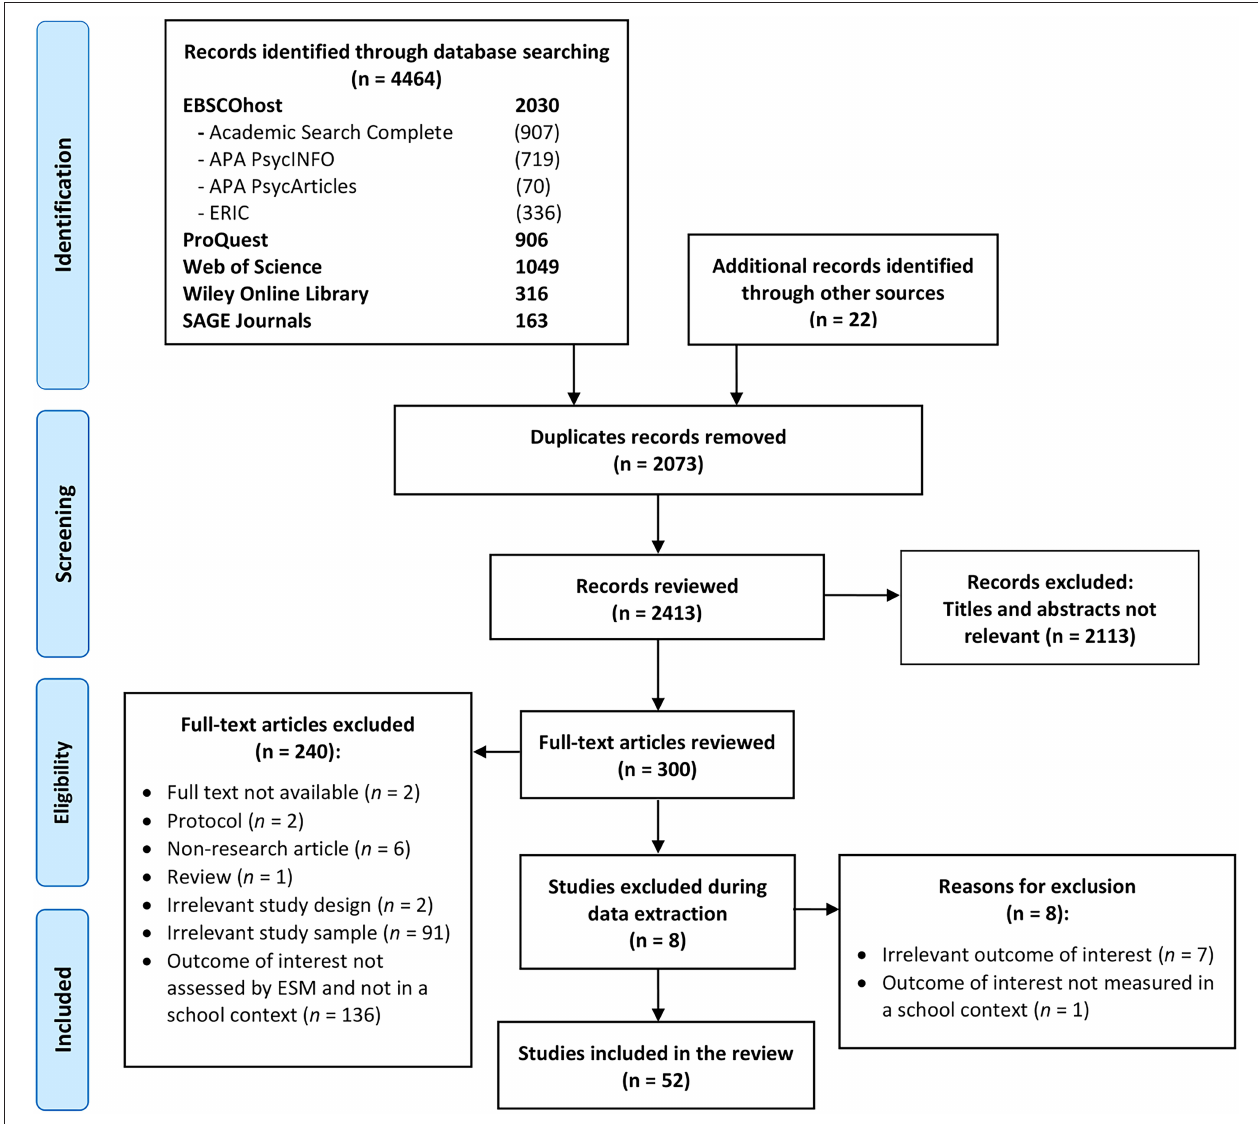
FIGURE 1 | PRISMA flow diagram for systematic review. Source: Moher et al. (2009).